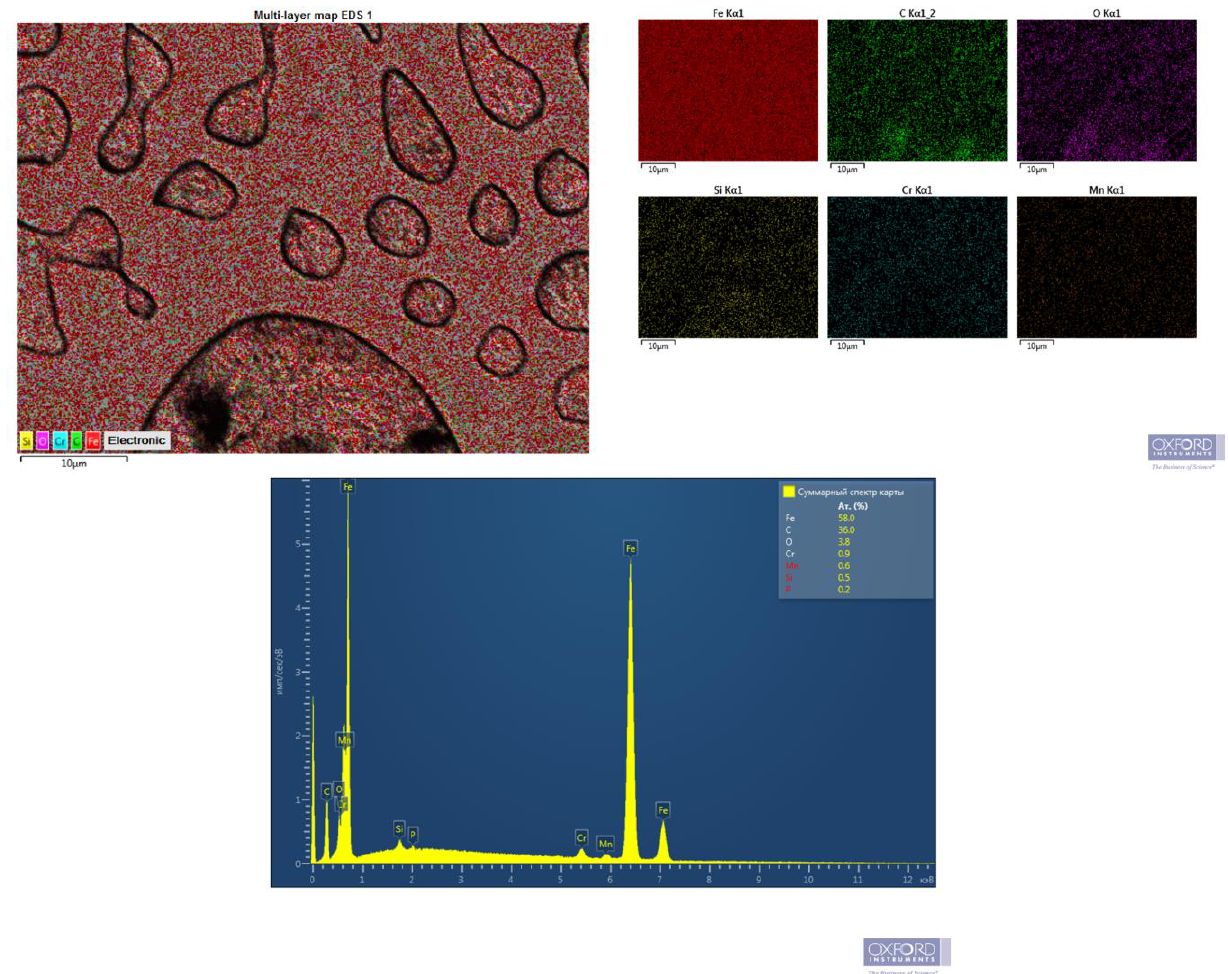
Figure 17. Distribution of the main chemical elements in the structure of sample 1.